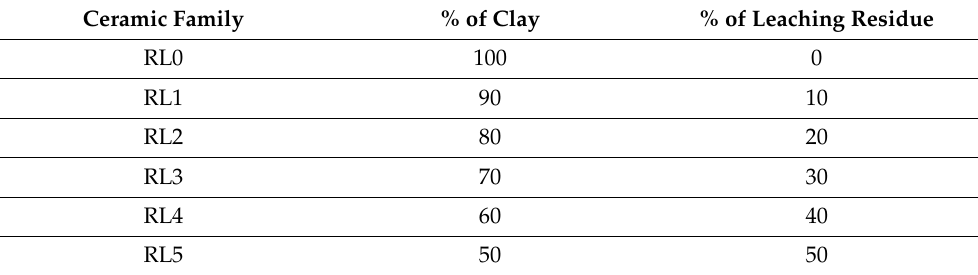
Table 1. Families of ceramic samples conformed with clay and leaching